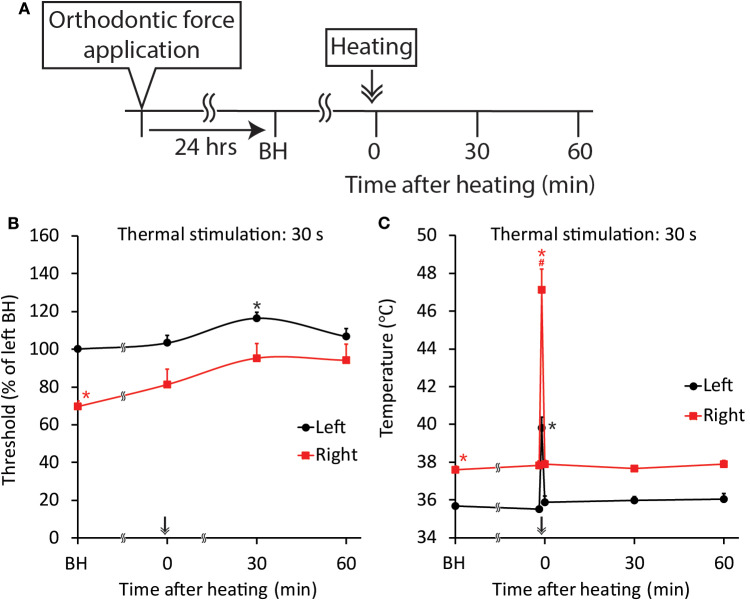
Effect of thermal stimulation on orthodontic treatment-induced excitation of the jaw-opening reflex. (A) Experimental procedure for the application of orthodontic force, thermal stimulation and the evaluation of jaw-opening reflex excitability. (B) Thermal stimulation (30 s, 45°C) significantly increased the right-side threshold for inducing the jaw-opening reflex. (C) Thermal stimulation (30 s, 45°C) significantly increased the gingival sulcus temperature on both sides. BH, before heating (thermal stimulation). Arrow & Heating: thermal stimulation. Two-way ANOVA, side: p < 0.05, time: p < 0.05, side × time: p < 0.05; Dunnett's post hoc test, *p < 0.05: vs. “BH of left,” #p < 0.05: vs. “BH of right”.